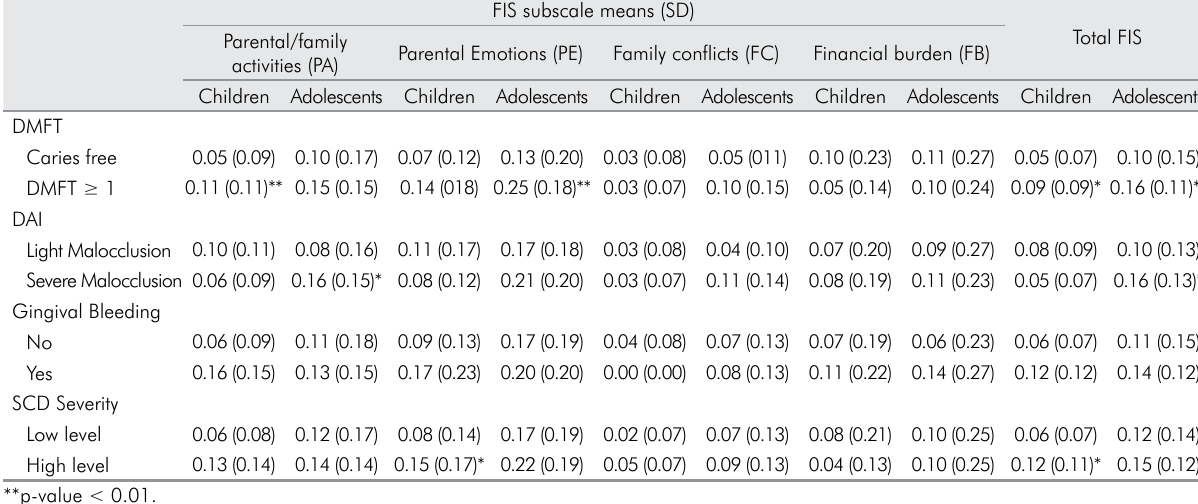
Table 3. Comparative means (%) between clinical condition categories for the same FIS subscale. FIS subscale means